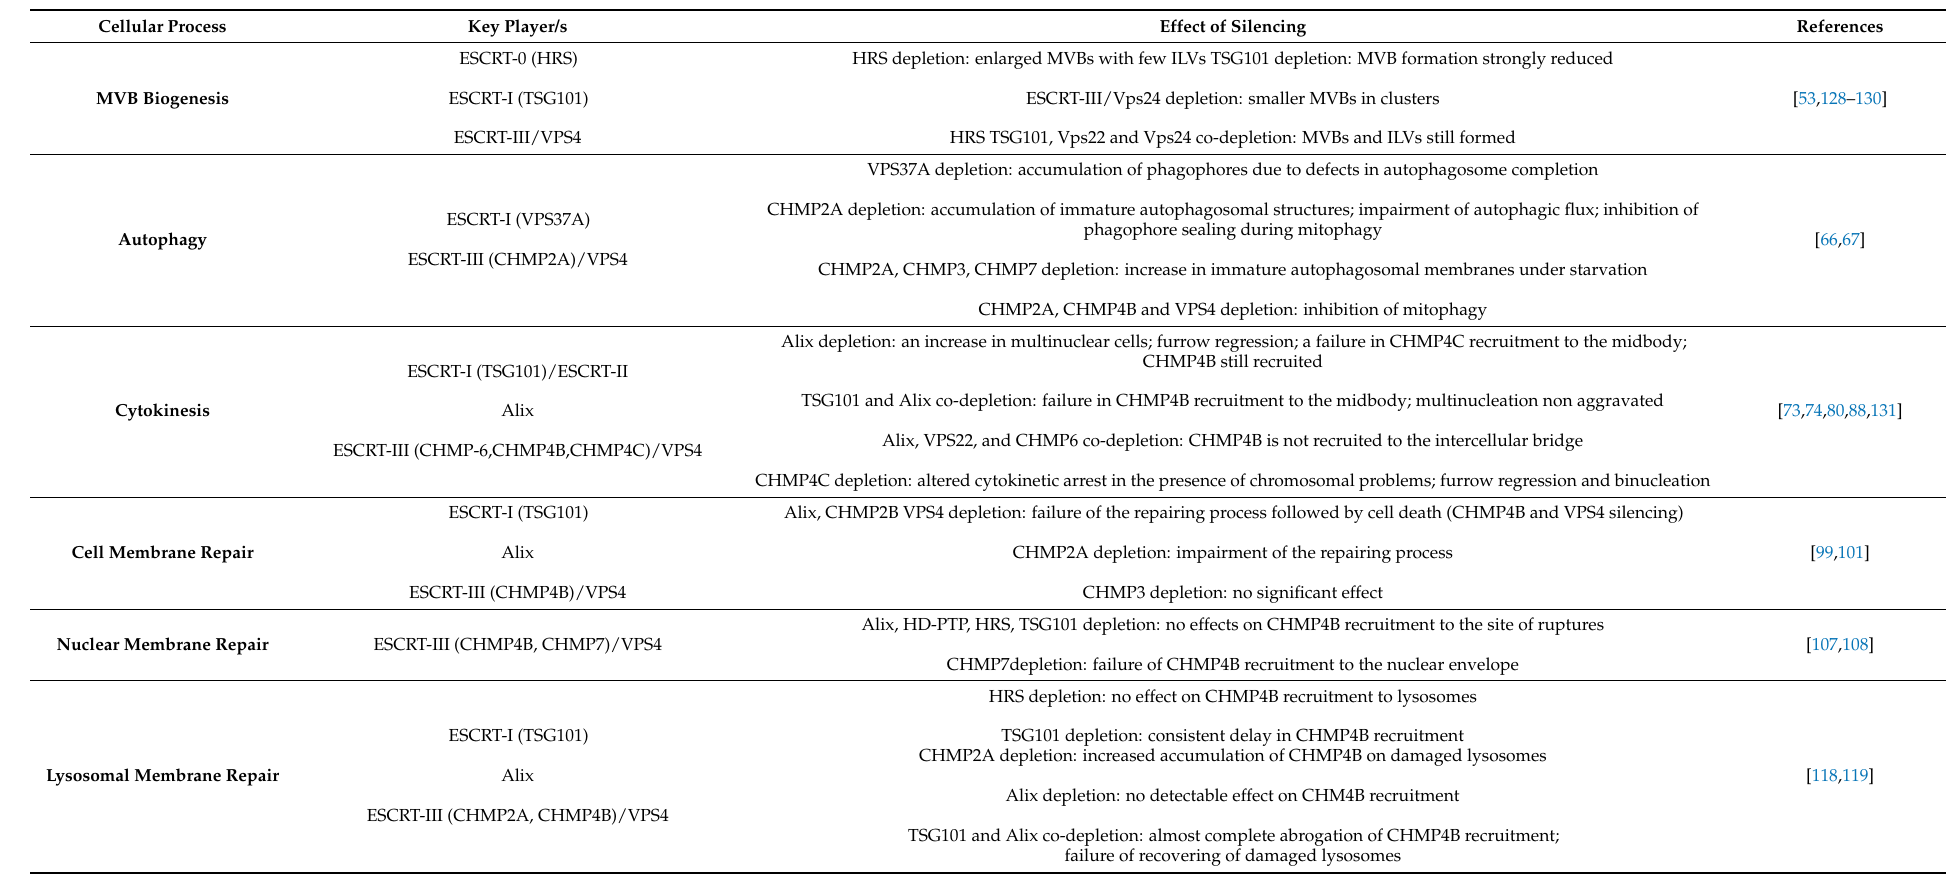
Table 1. Table reports the key players for the major processes in mammalian cells involving ESCRTs. The results of silencing studies supporting the role played by these key players are also